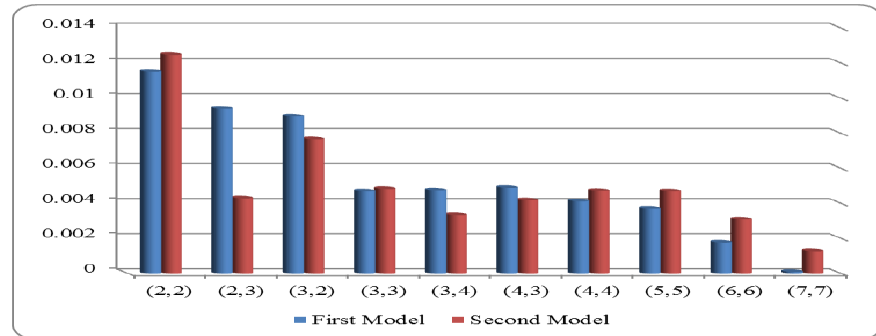
Figure 2. MSEs of Figure 2. MSEs of ˆ R 1 and ˆ R 2 for both models at R = 0.608.